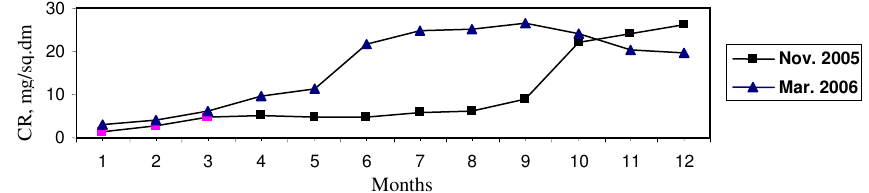
Figure 5. Progressive corrosion rate (CR) of aluminium under outdoor exposure at an urban